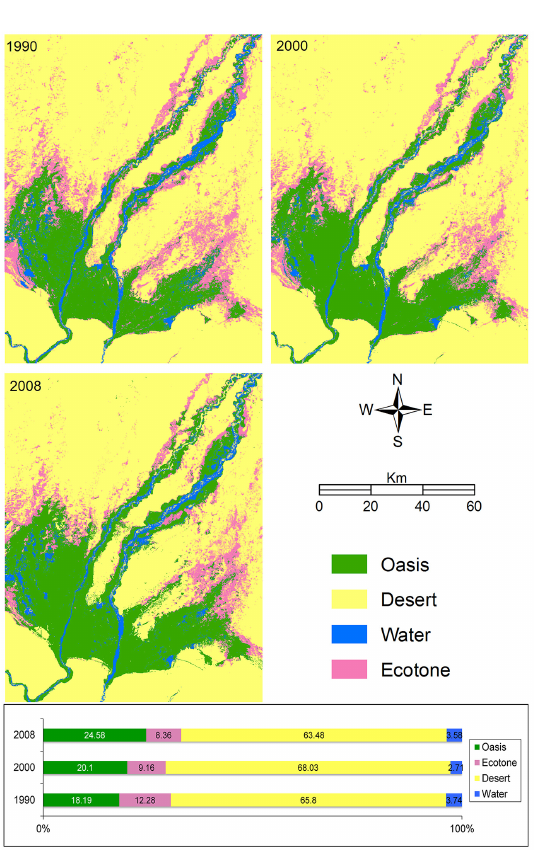
Figure 2. Land cover maps of the Hotan Oasis for the years 1990, 2000 and 2008 and the respective extents of land cover classes by percentage (study area: 1273710ha).